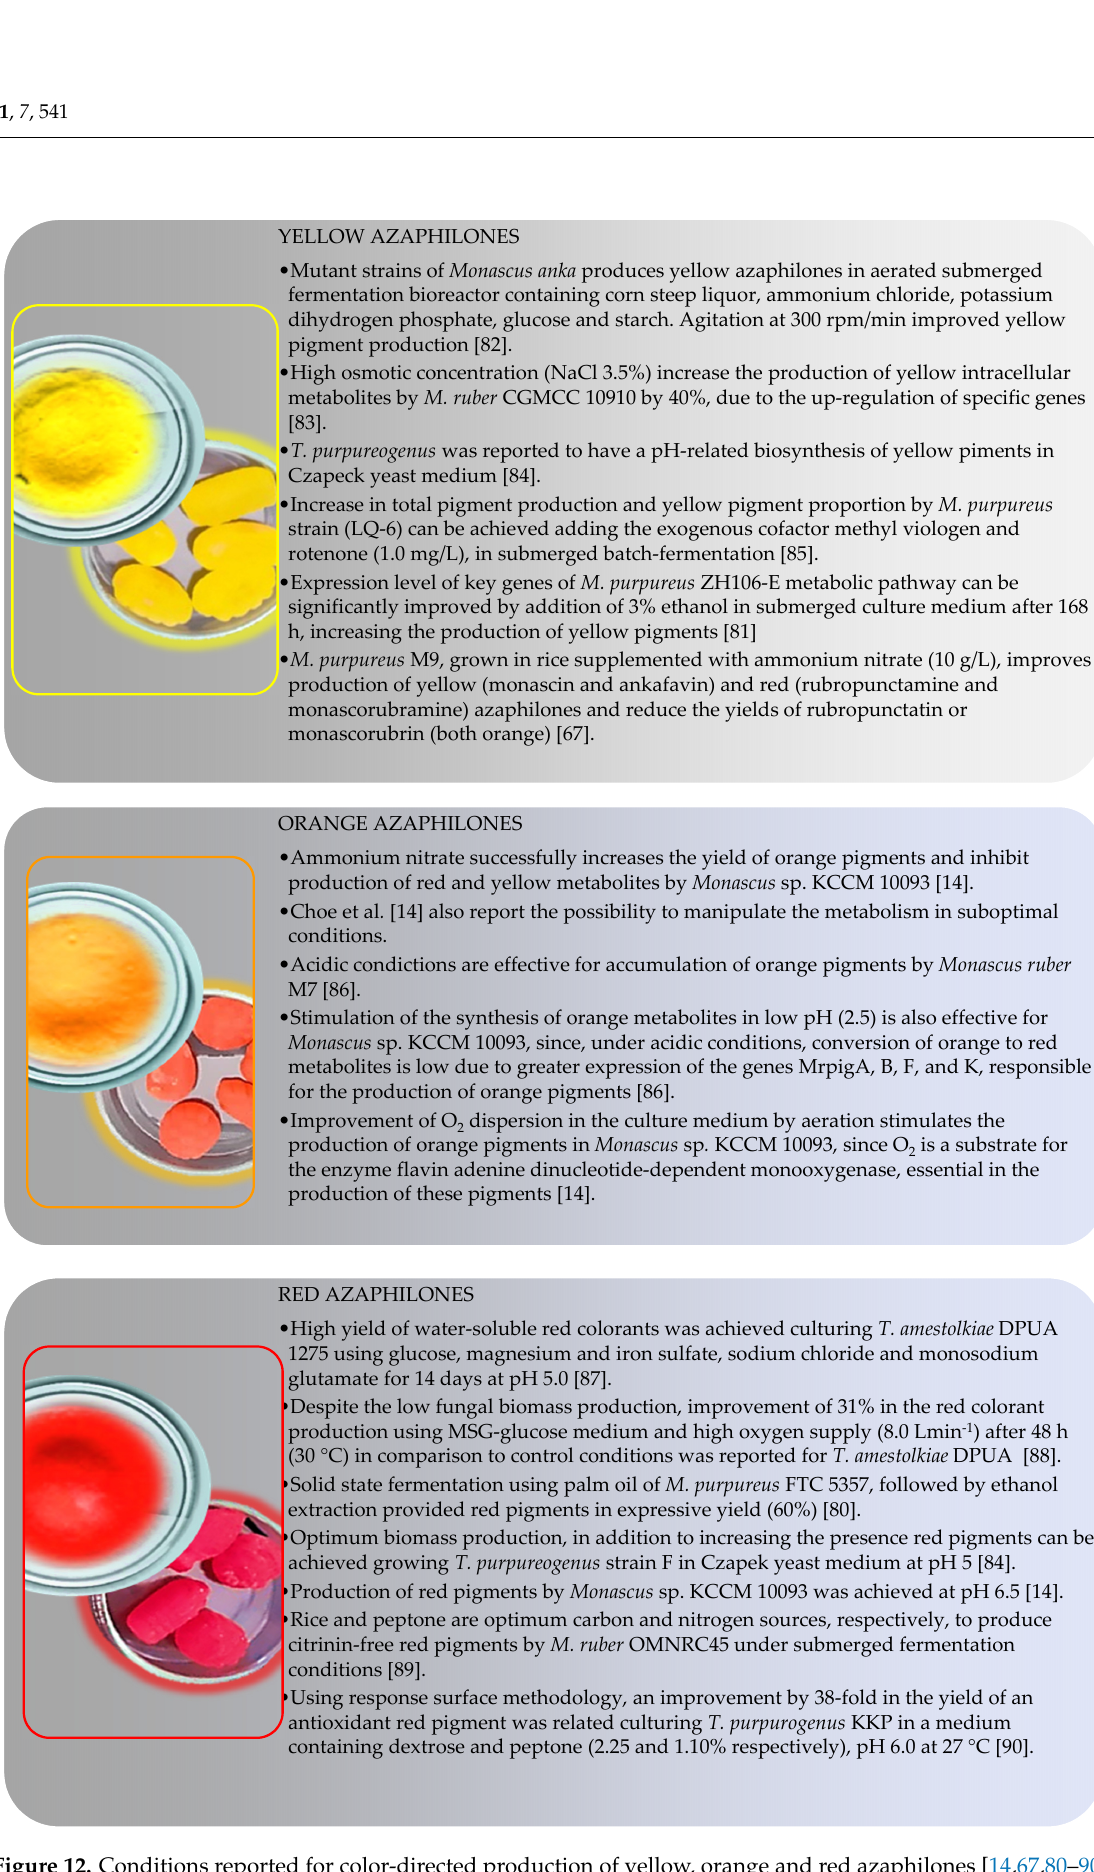
Figure 12. Conditions reported for color-directed production of yellow, orange and red azaphilones